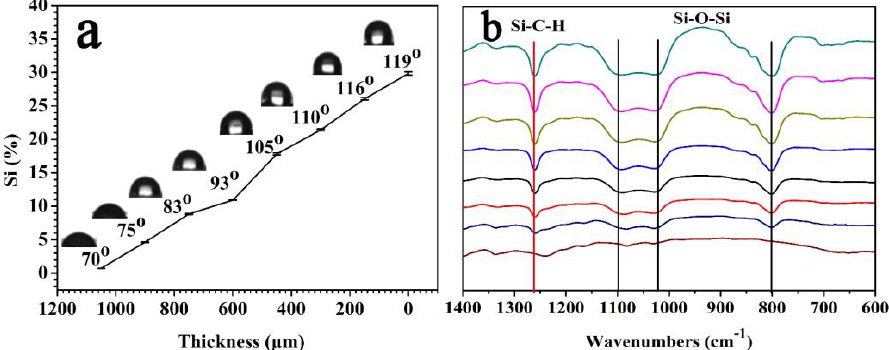
Figure 6. ( a ) Concentration of Si element in the slices along the vertical direction from top to bottom by SEM–EDS and corresponding contact angles of the slices. SD 0.2, n = 3. ( b ) FT–IR spectra of the slices (top to bottom).